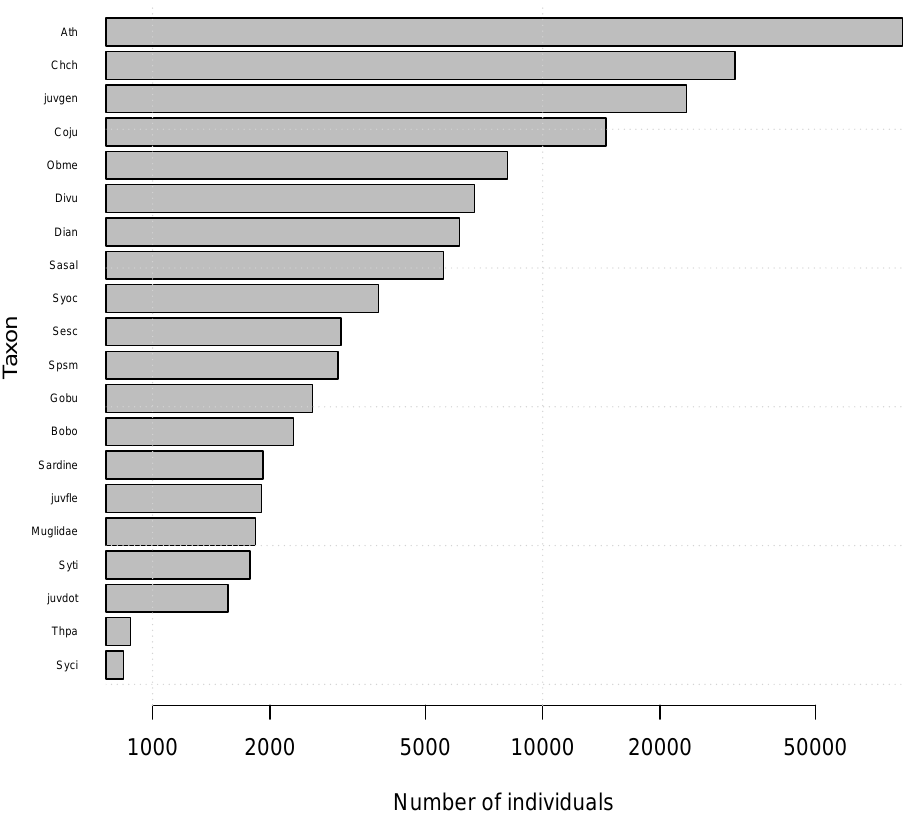
Figure 3. The total number of individuals recorded for each of the 20 most abundant taxa. See Table names for Latin binomials.